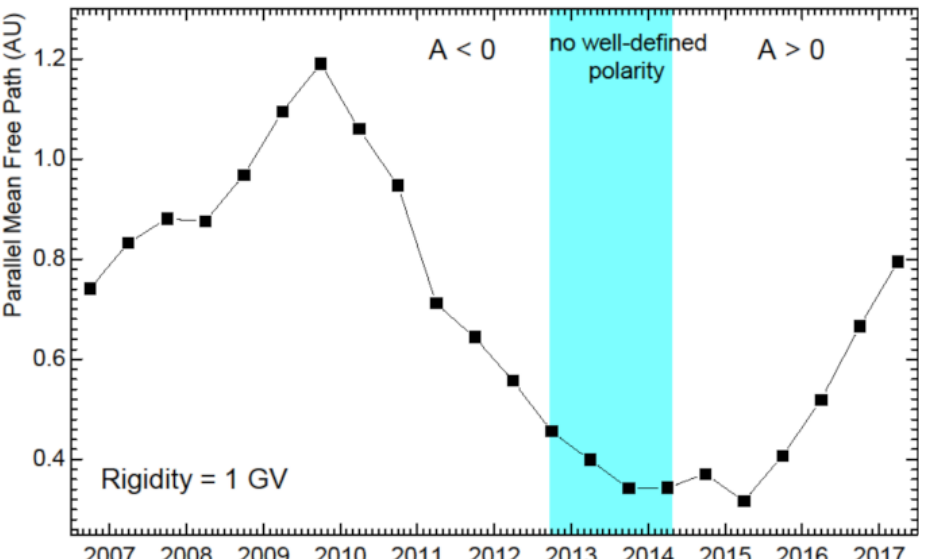
Figure 4. Parallel MFP λ (cid:107) , at the Earth based on the simulations (this work) of 1 GV protons and anti-protons from July 2006 to May 2017. The period with no-well-defined HMF polarity is indicated by the shaded band during which the HMF polarity reversal occurred, changing from A < 0 to A > 0, the latter being the present modulation